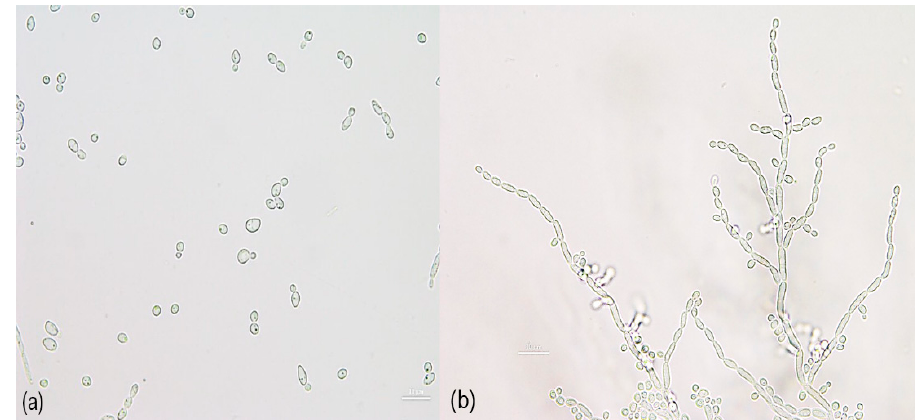
Figure 5. Morphology of Limtongella siamensis nov. (DMKU-JMGT1-45 T ): (a) budding cells in a YM broth after three days at 25 °C; ( b ) pseudohyphae formed on PDA after three days at 25 °C. Bars, 10 µm .